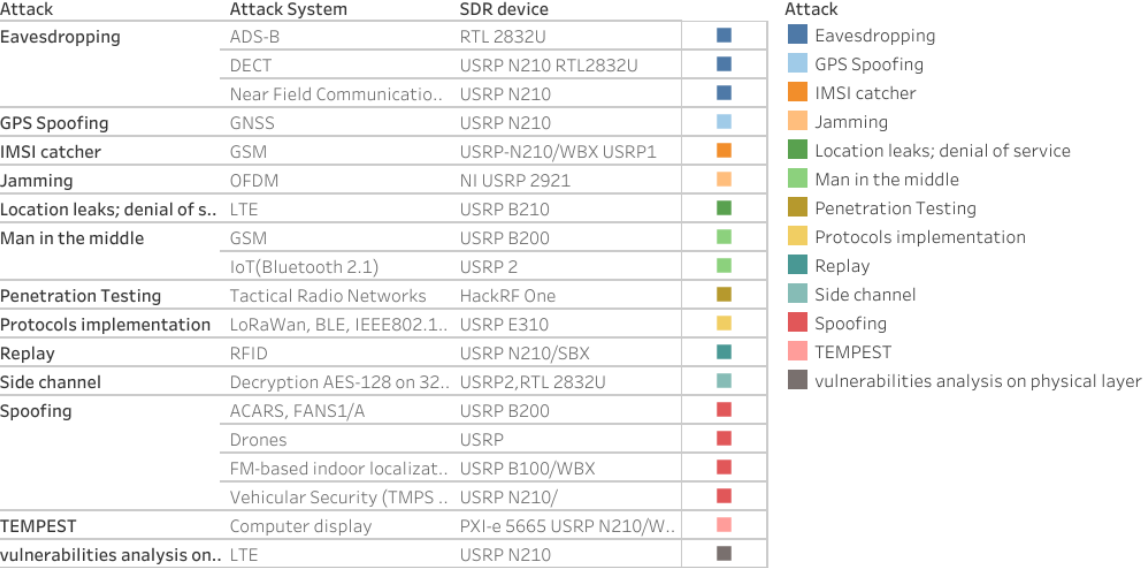
Figure 1. Physical attack and attack system by SDR devices.